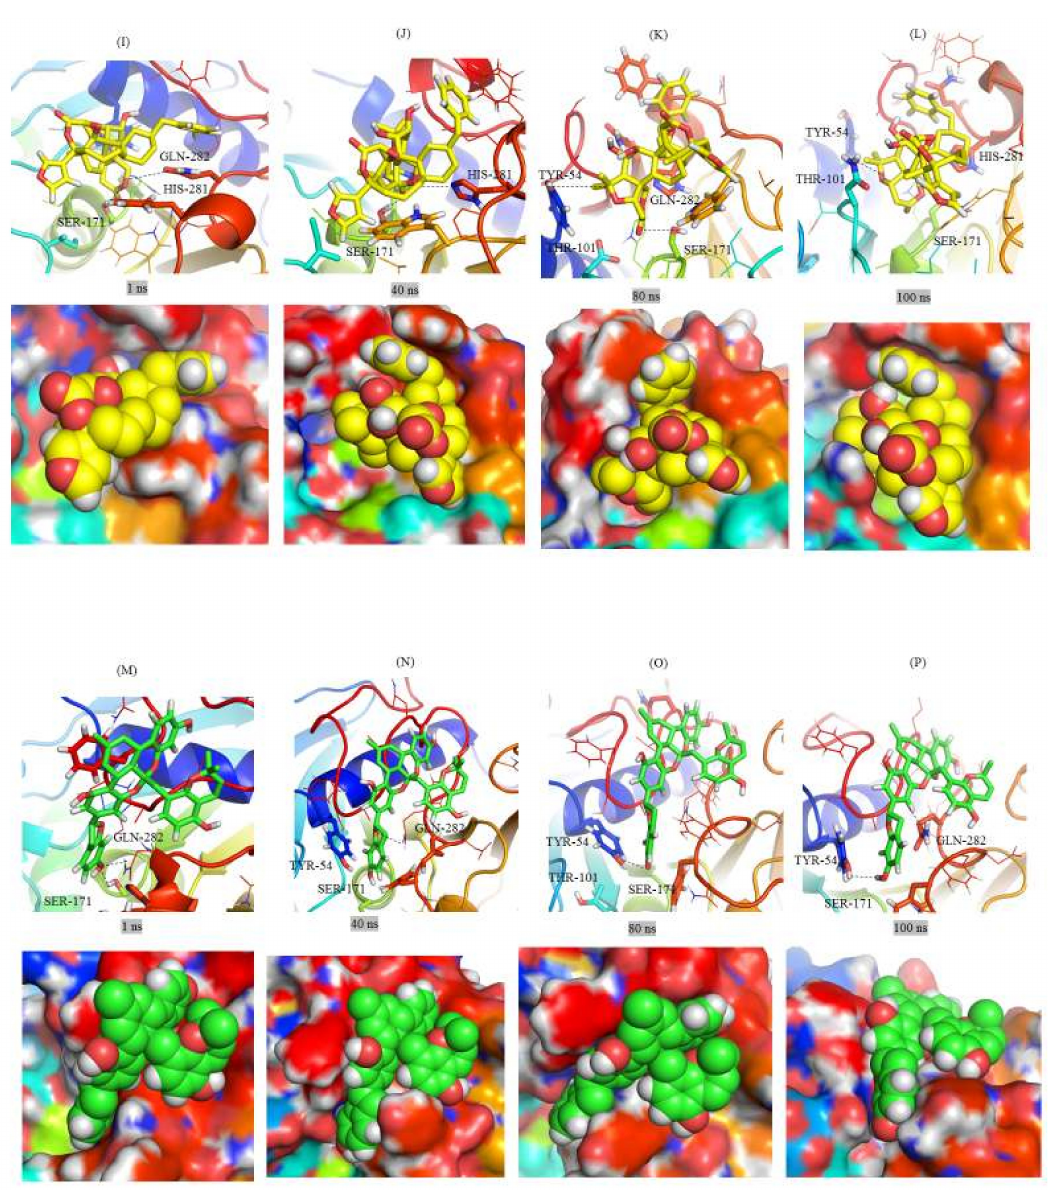
Figure 5. Ligands orientations during the different time scales. The MD trajectory of ( A – D ) Mrlip1- RHC80267, ( E – H ) Mrlip1-ZINC95914464, (I–L) Mrlip1-ZINC85530919, and ( M – P ) Mrlip1-ZINC85530320 complexes during different time intervals. The Mrlip1 is shown in cartoon as well as surface representation. Catalytic pocket residues are shown in the stick